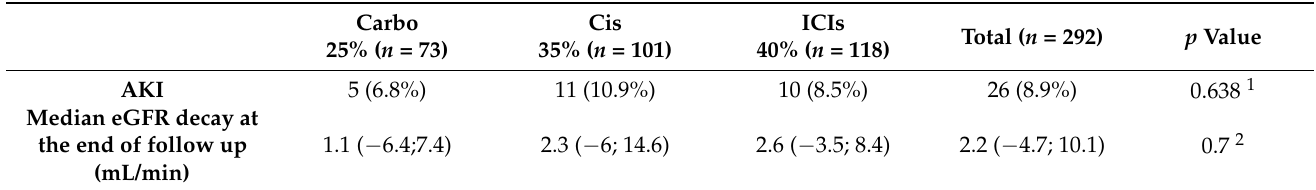
Table 3. Results: primary and secondary endpoints. 1 : Pearson’s Chi-square test; 2 : Kruskal–Wallis test.